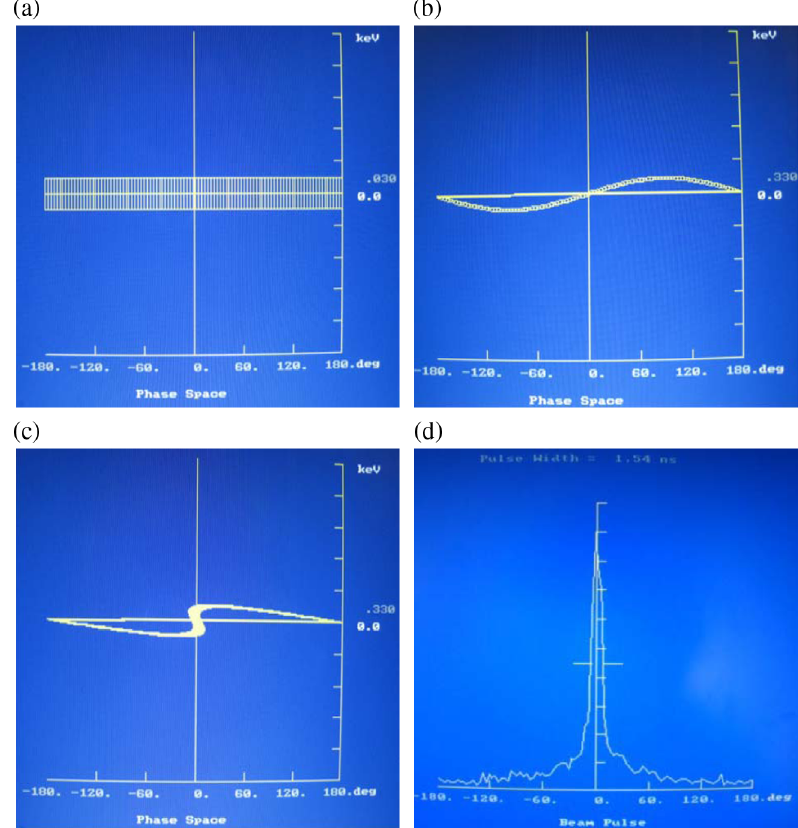
FIG. 2. Evolution of the modulated beam in the longitudinal phase plane. (a) Initial phase-energy distribution from ion source with energy spread of 0.1%. (b) Phase energy of the extracted beam after introducing a voltage modulation. (c) Phase energy at L ¼ F . (d) Beam pulse at L ¼ F .